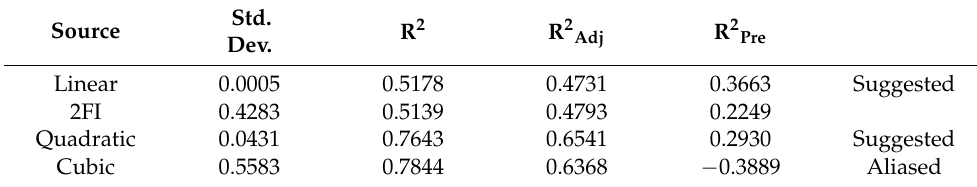
Table 3. Comparison of Model